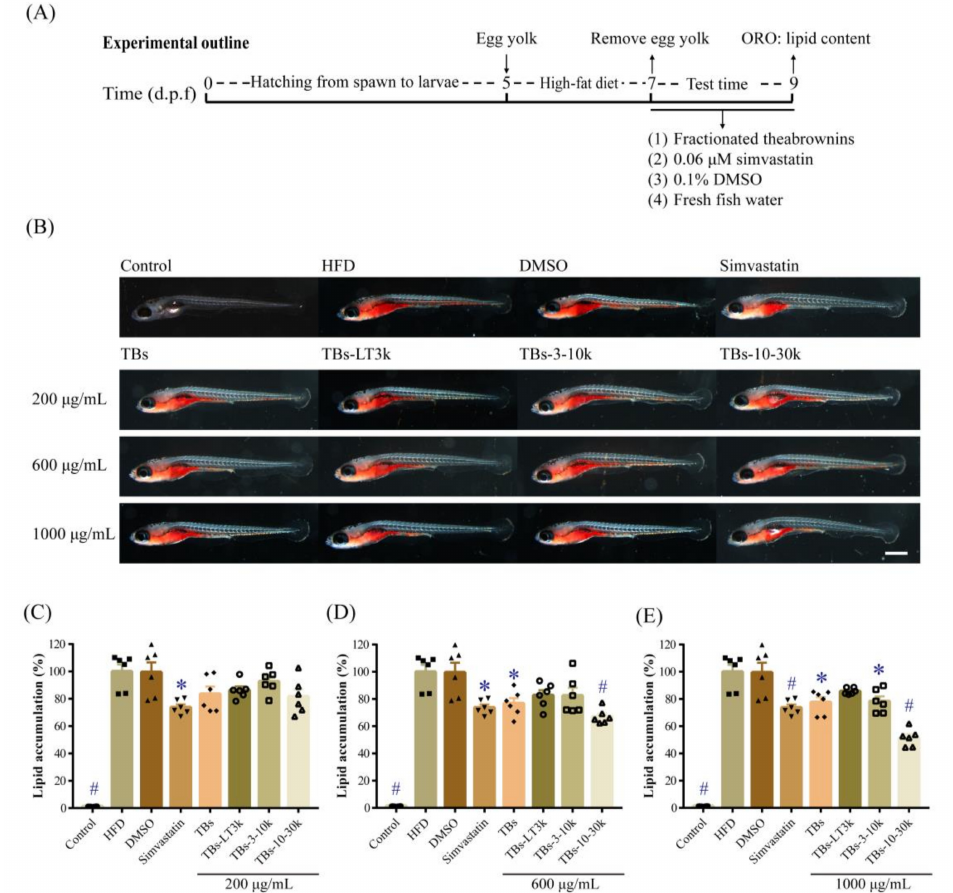
Figure 2. Hypolipidemic e ff ect of theabrownins (TBs) and fractionated theabrownin samples with di ff erent molecular weights in high-fat-induced obesity zebrafish. ( A ) Experimental outline of zebrafish model. ( B ) Zebrafish stained with oil red O and visualized under a microscope magnified 30